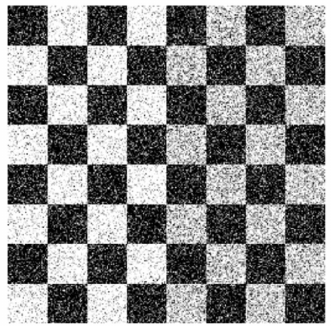
Figure 13. Test image plus noise.